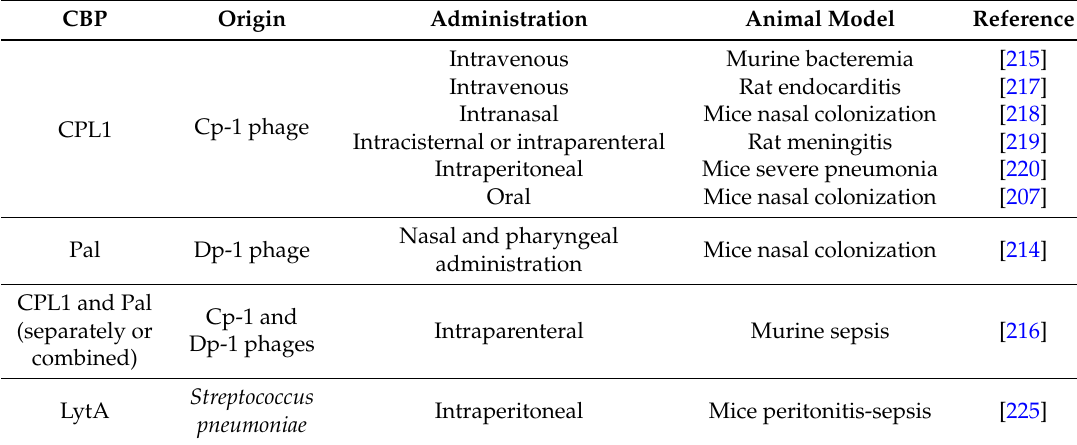
Table 1. In vivo assays of pneumococcal CBPs as enzybiotics on animal